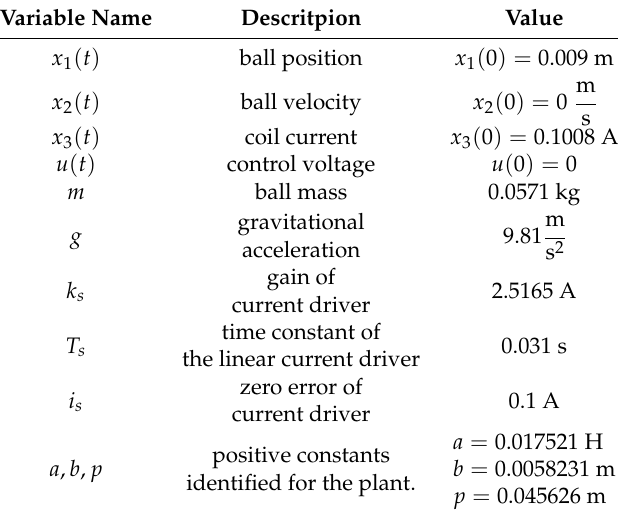
Table 1. Variables used in the mathematical description of a laboratory magnetic levitation